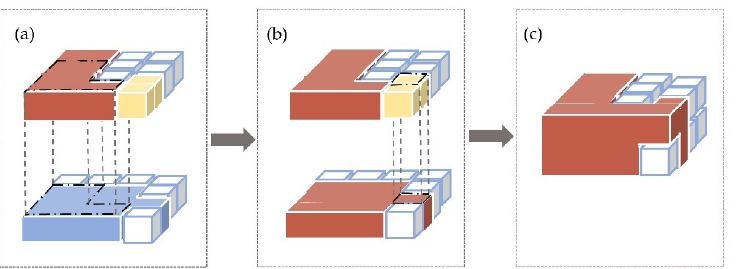
Figure 4. Schematic merging of the spatial results for the IST-cube in the temporal domain. Red, yellow, and blue cubes represent individual cubes resulting from merging in the spatial domain. ( a ) Red and blue IST-cubes in the merge judgment in the temporal domain; ( b ) red and yellow IST-cubes in the merge judgment in the temporal domain; and ( c ) final merge into a single cube.